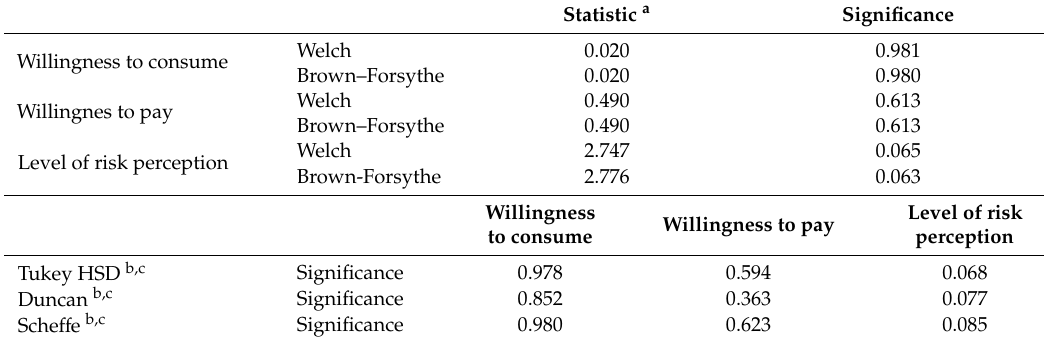
Table 4. Robust tests and post hoc tests results for consumers’ willingness to pay, willingness to consume, and perception of risks tied to